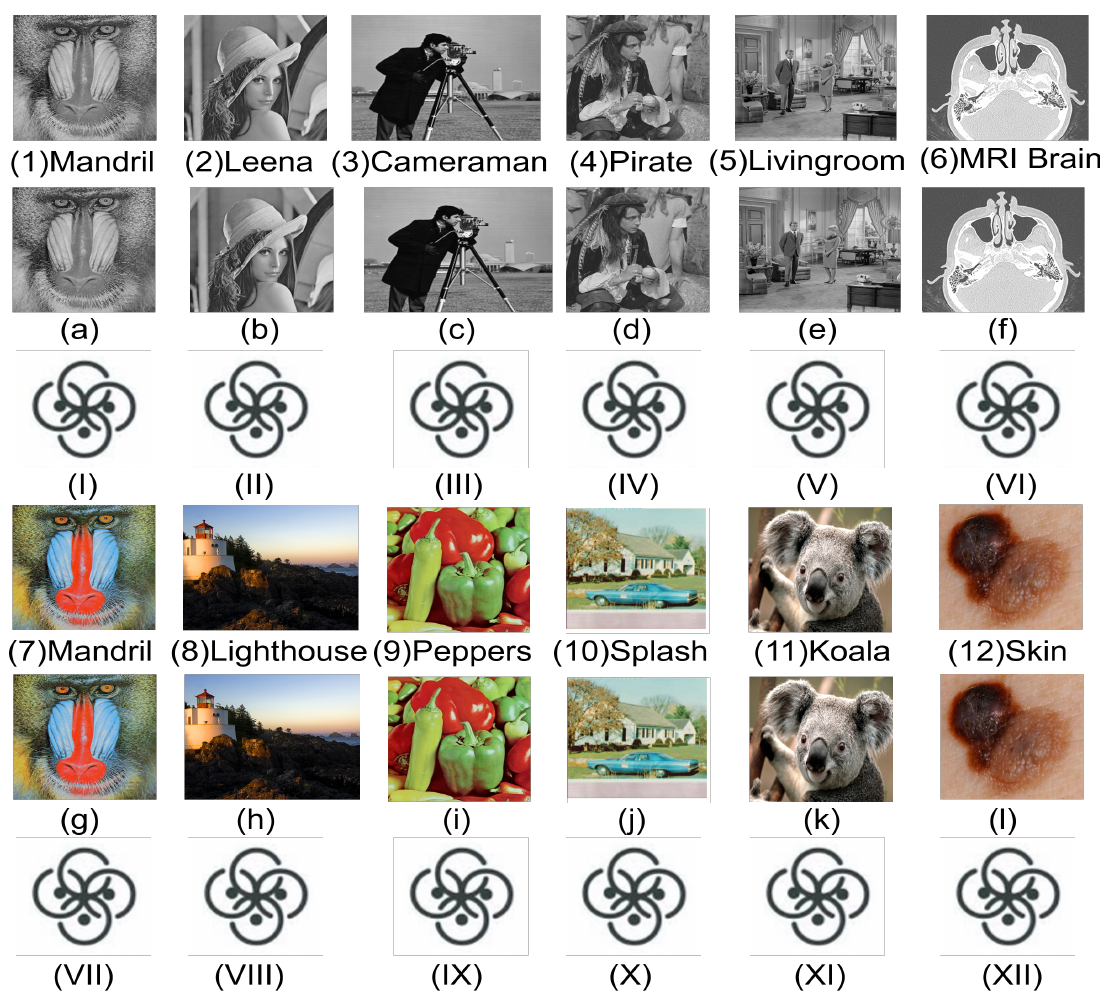
Figure 7. Gray-scale cover images ( 1 – 6 ) with corresponding watermark images ( a – f ) and extracted watermark images ( I – VI ). Color cover images ( 7 – 12 ) with corresponding watermark images ( g – l ) and extracted watermark images ( VII – XII ) under zero